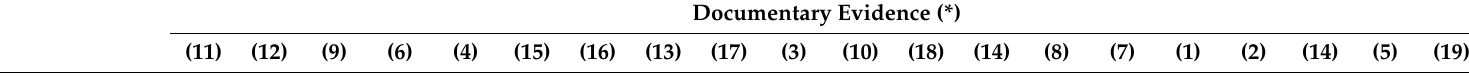
Table 2. Applicability of the GSBPM to